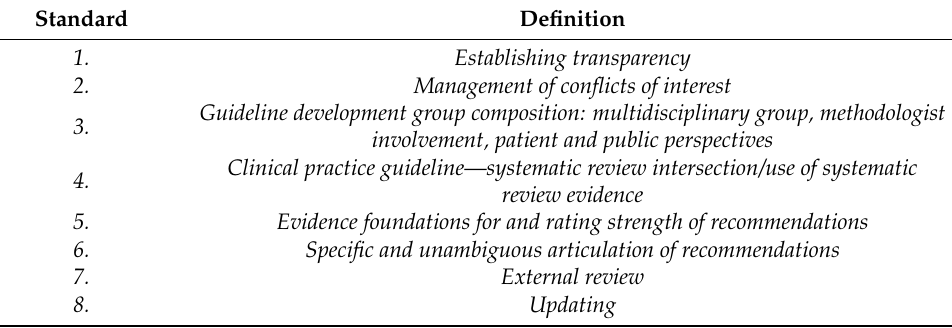
Table A1. Standards of trustworthiness, Institute of Medicine [28].